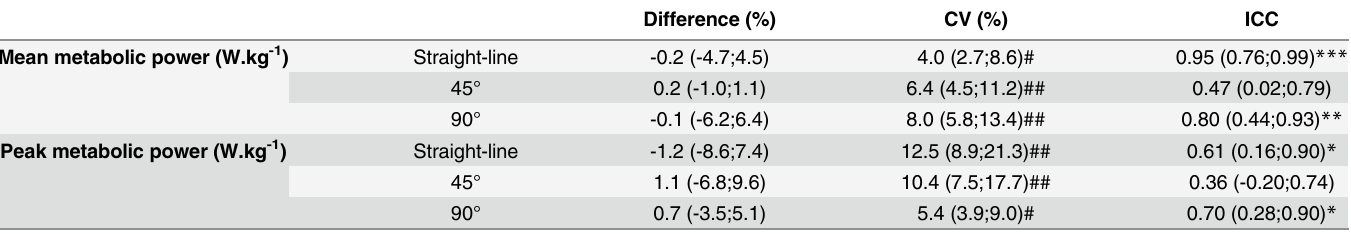
Table 1. Reliability of some metabolic power variables collected with the new timing methodology and timing gates during sprints with and with- out change of